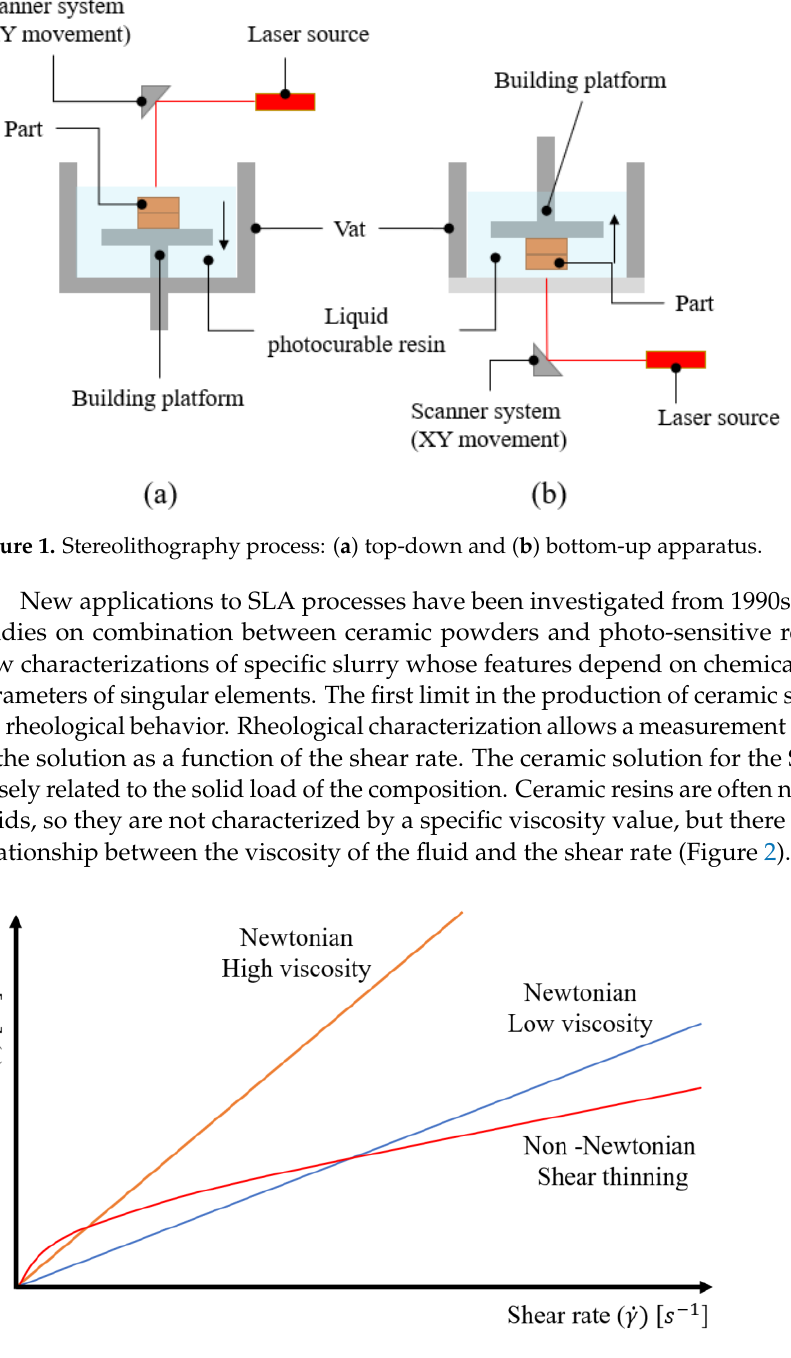
Figure 2. Flow curve. In rheology, the force is expressed as shear stress and the speed is expressed as shear rate.